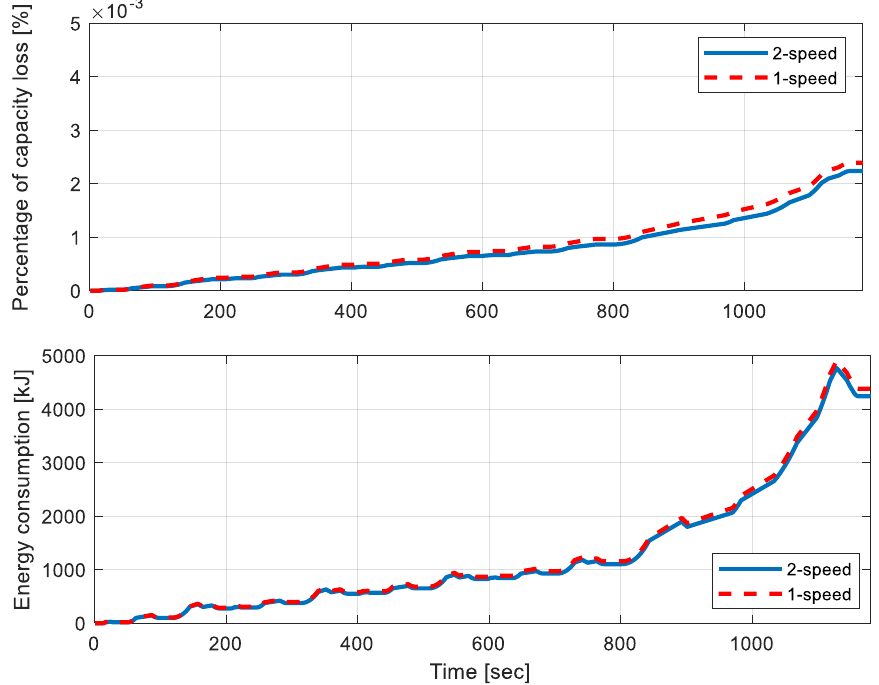
Figure 12. Simulation results of battery capacity loss percentage and energy consumption under NEDC conditions.